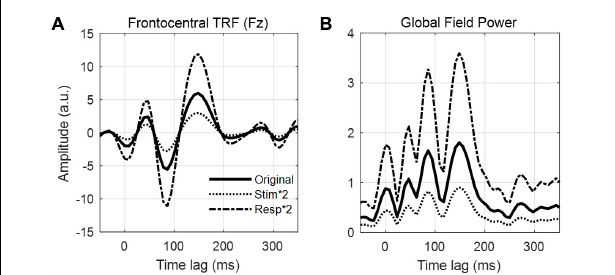
FIGURE 5 | Effects of stimulus-response normalization on TRF amplitude. (A) Frontocentral TRF (channel Fz) calculated from 15 min of speech-EEG data using the envelope feature. The plot shows the TRFs calculated using the original, unnormalized data (bold trace), the stimulus features scaled by a factor of 2 (dotted trace) and the neural response scaled by a factor of 2 (dashed trace). (B) The global field power – calculated as the standard deviation across all 128 EEG channels – for the same 3 conditions as in panel (A)